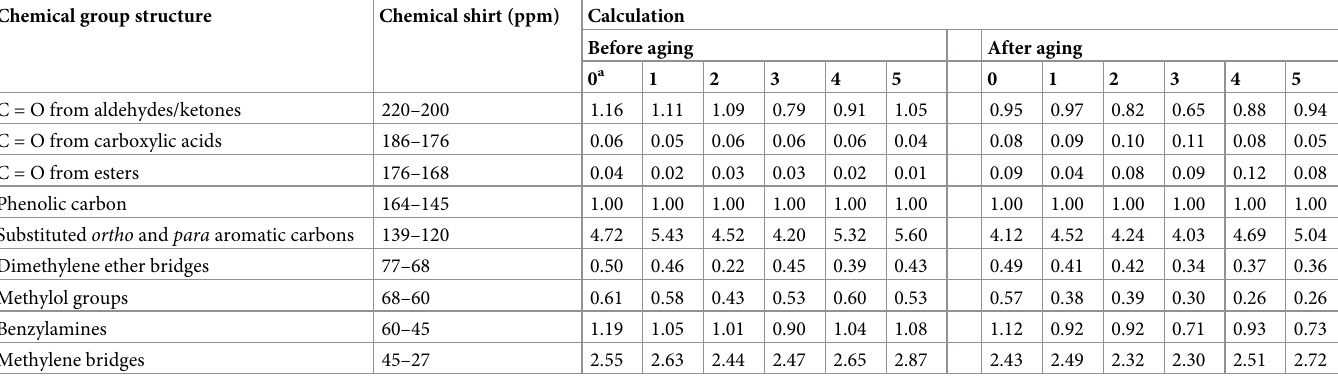
Table 5. 13 C NMR assignment and quantitative analysis of chemical groups for BMPF before and after aging for 960 h. Chemical group